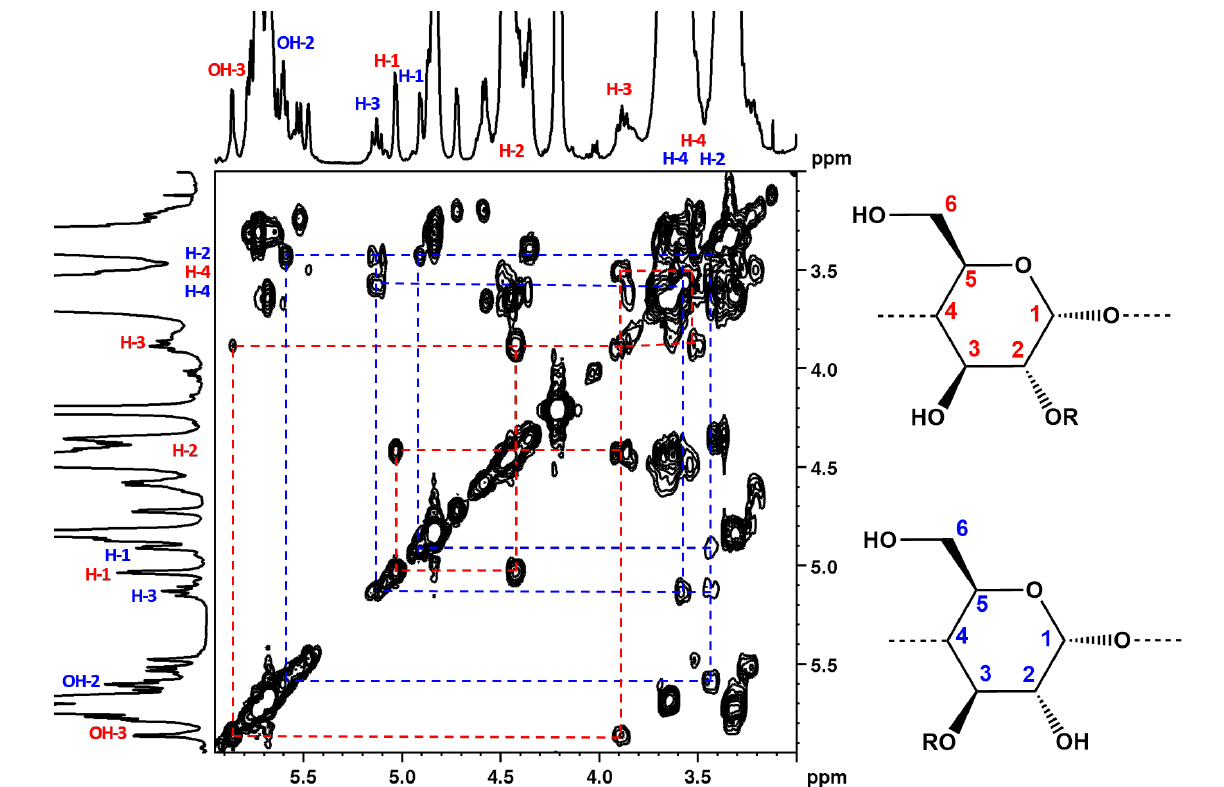
Figure 5. COSY experiment evidencing different substitutions at C-3 (blue) and C-2 (red) .